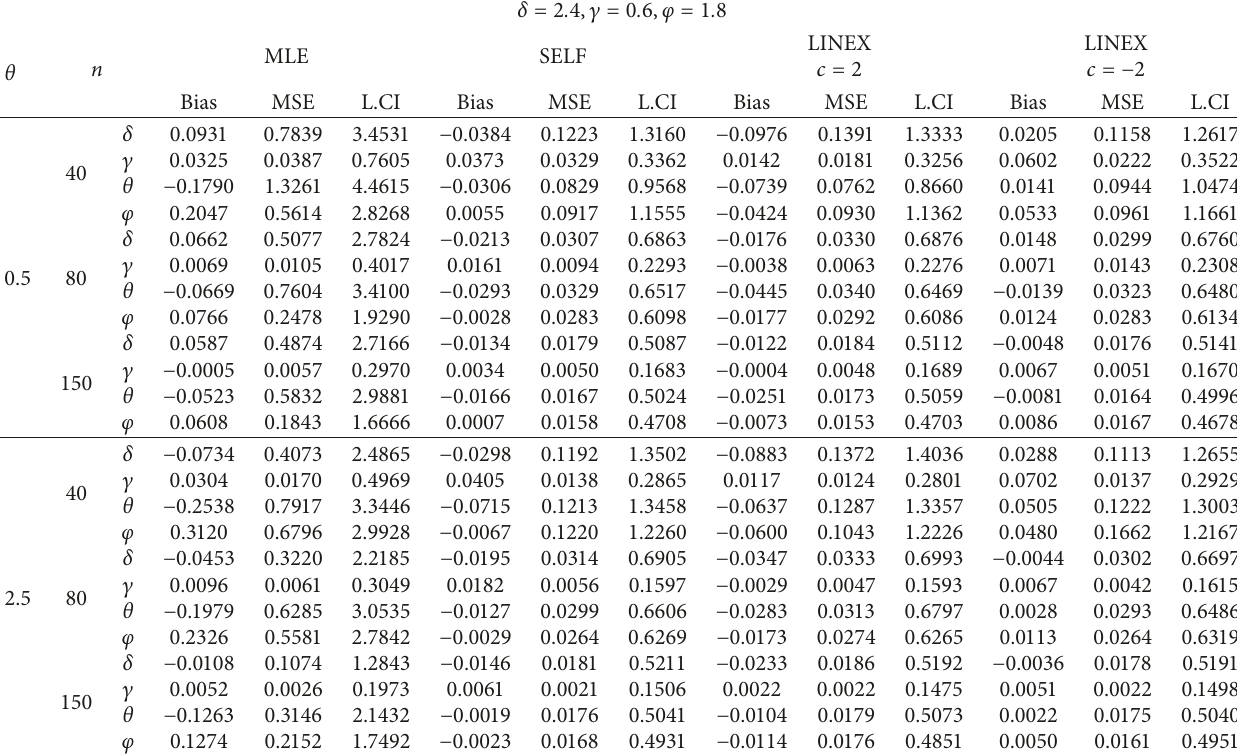
Table 7: Bias, MSE, and L. CI for MLE and BE for case